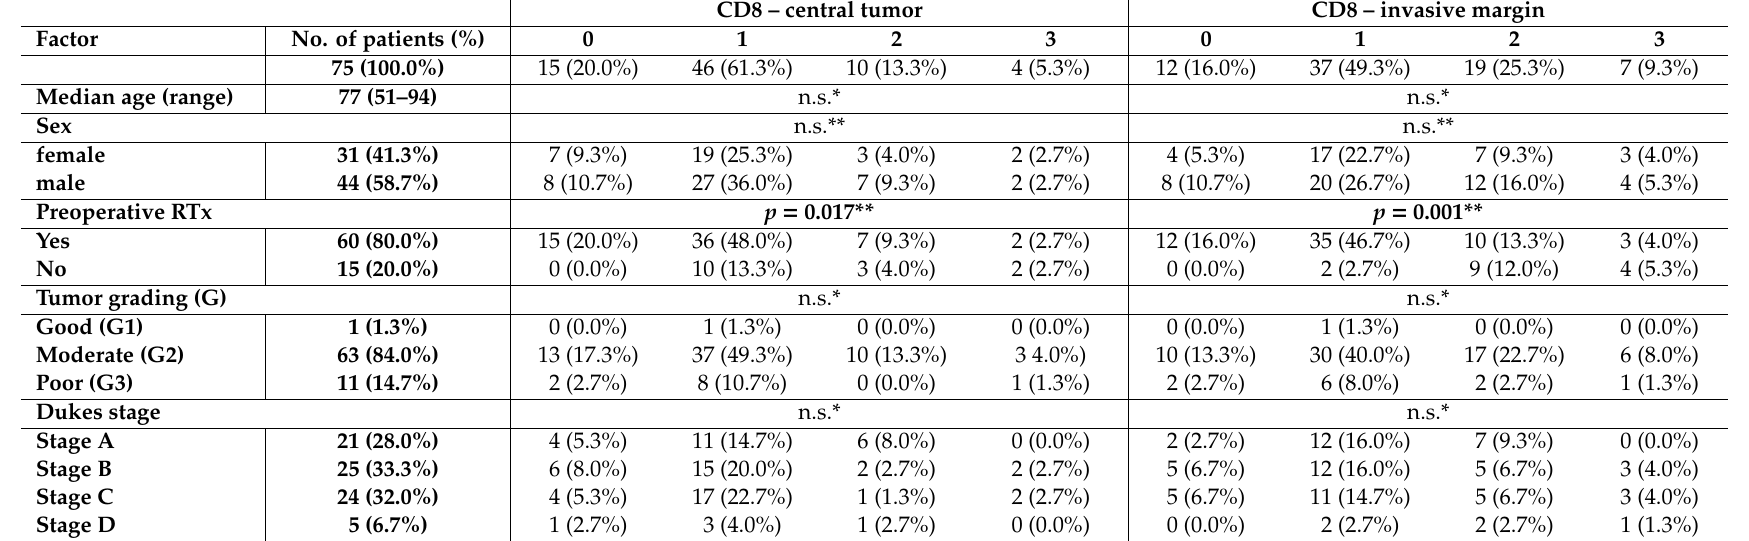
Table 2. Patient and tumor characteristics in relation to the level of CD8 T cell expression determined analogously on full tissue sections. CD8 – central tumor CD8 – invasive